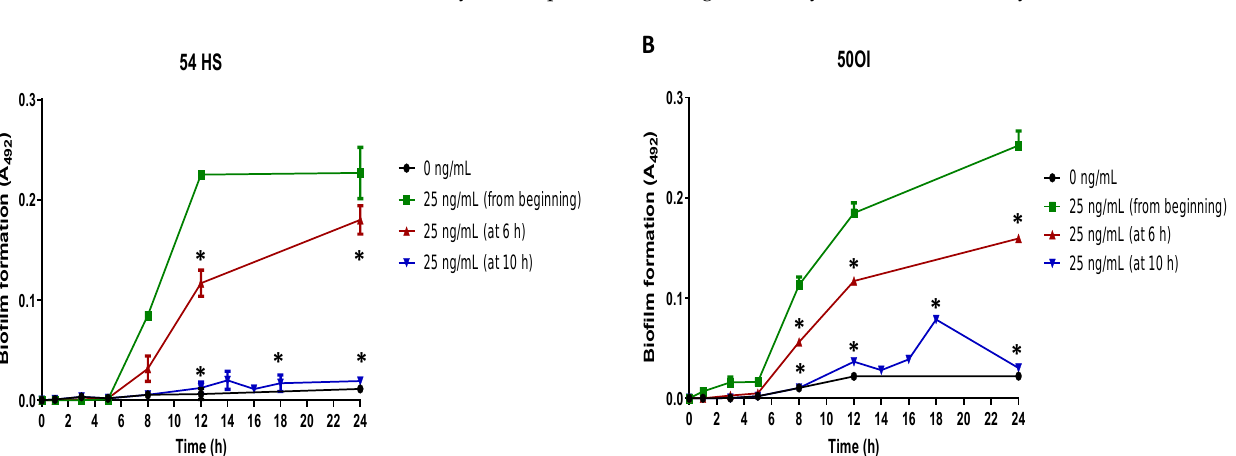
Figure 3. Kinetics of biofilm formation in non-biofilm-forming isolates. Four non-biofilm-forming isolates from different isolation sources (( A ) HC, healthy conjunctiva; ( B ) OI, ocular infection; ( C ) HS, healthy skin and ( D ) PJI, prosthetic joint infection) were induced for biofilm by proteinase-3 treatment. Asterisk * indicates significant difference ( p < 0.05) concerning the control (bacteria without protease). The statistical analysis was performed using a one-way ANOVA with Tukey’s test.